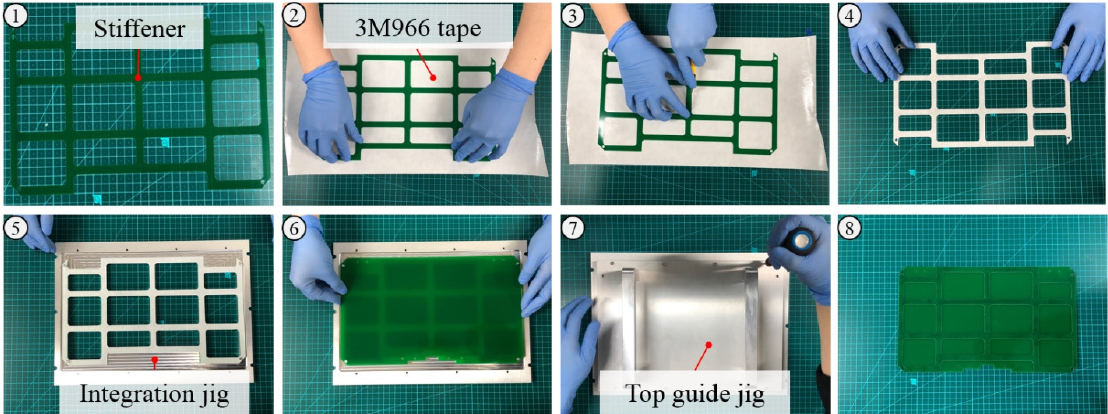
Figure 4. Integration process of a stiffeners on the PCB panel.